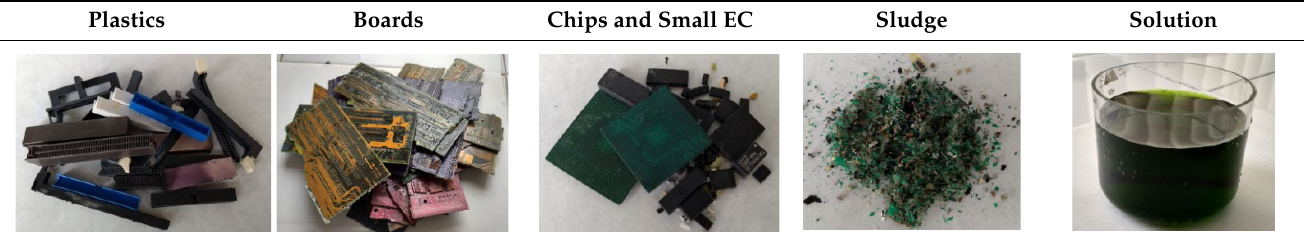
Table 6. Material fractions resulted from the dismantling process. Plastics Boards Chips and Small EC Plastics Boards Plastics